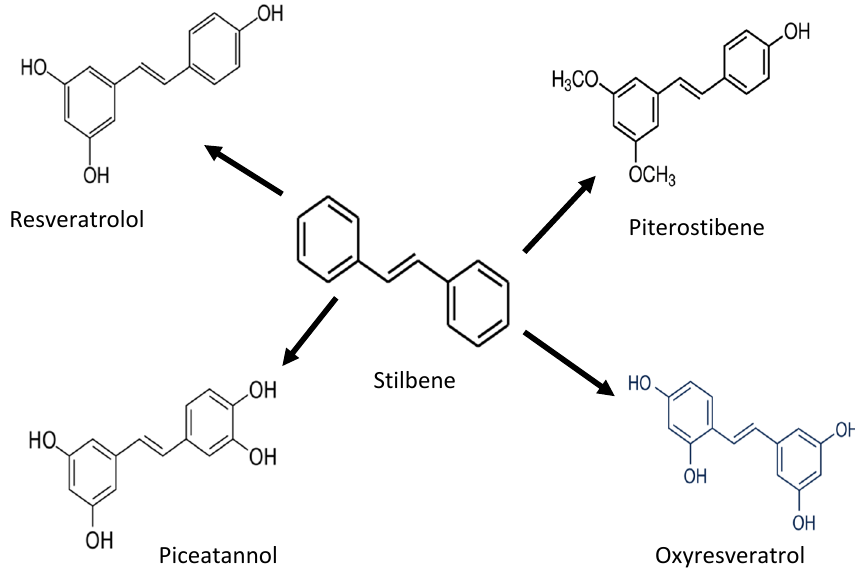
Figure 4. Chemical structure of stilbene and its derivatives.